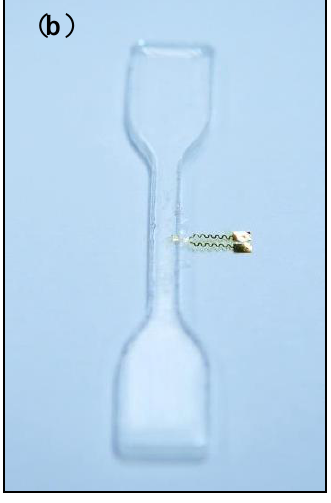
Figure 5. Photographs of an embedded sensor in ( a ) an O-ring and ( b ) a test specimen.